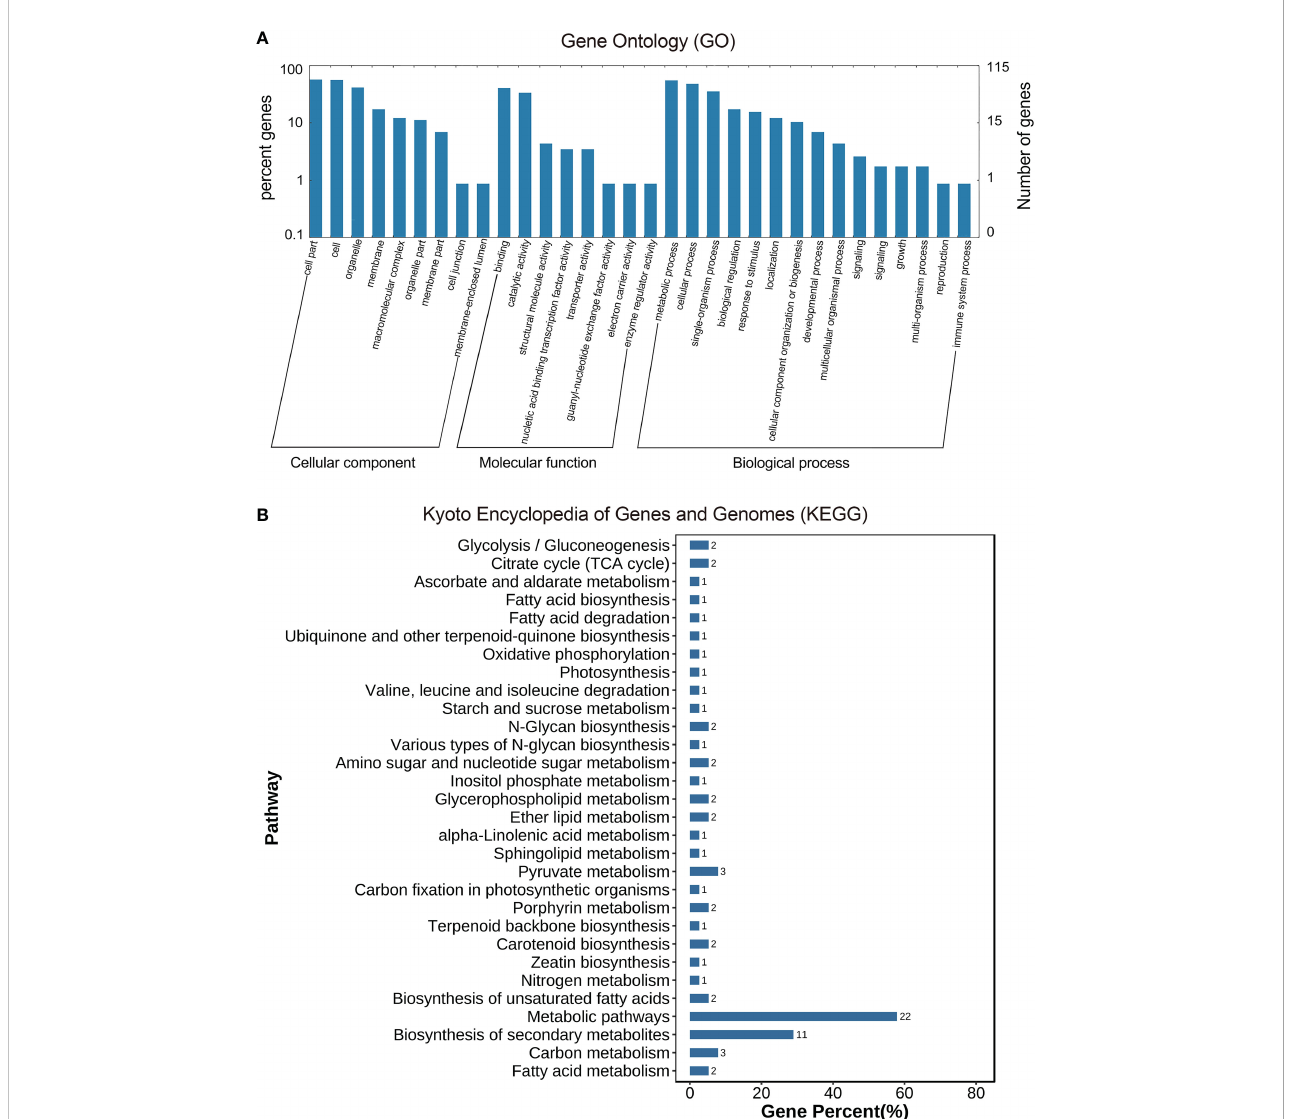
FIGURE 3 Homology search of the transcriptome-derived 359 unigenes of the three varieties, Florex gold (FG), Rehmannii (RE) and Black Magic (BM) 359 unigenes against the GO database (A) assignment into biological process, molecular function and cellular component at the third level, and KEGG database (B)